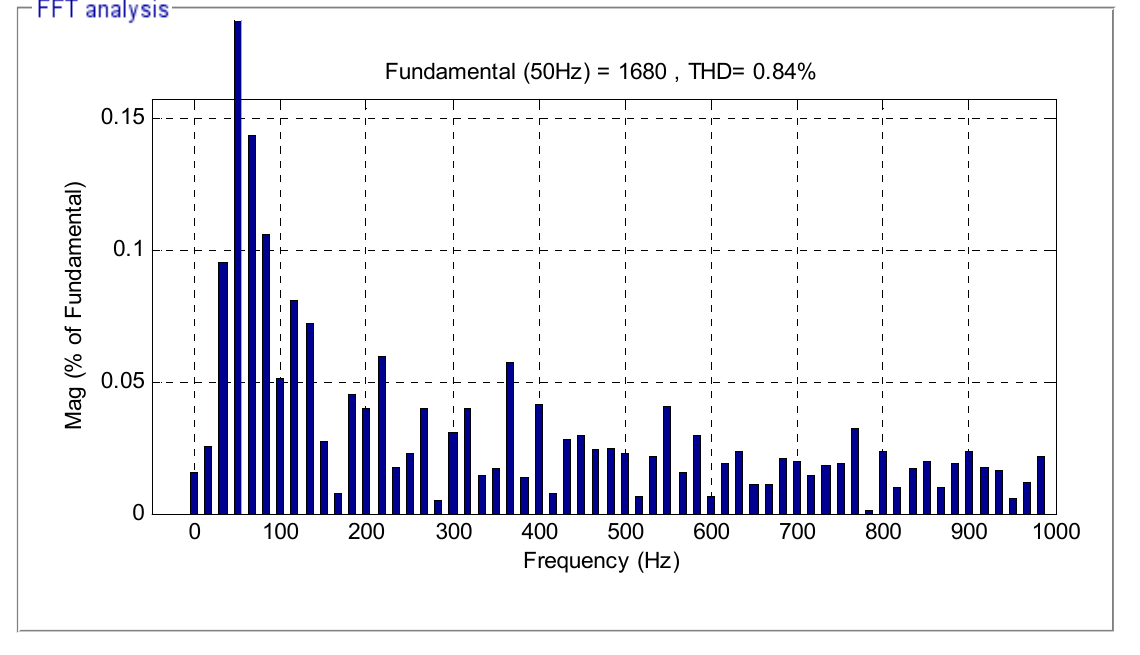
Figure 24. THD of current (PI-DARPC).